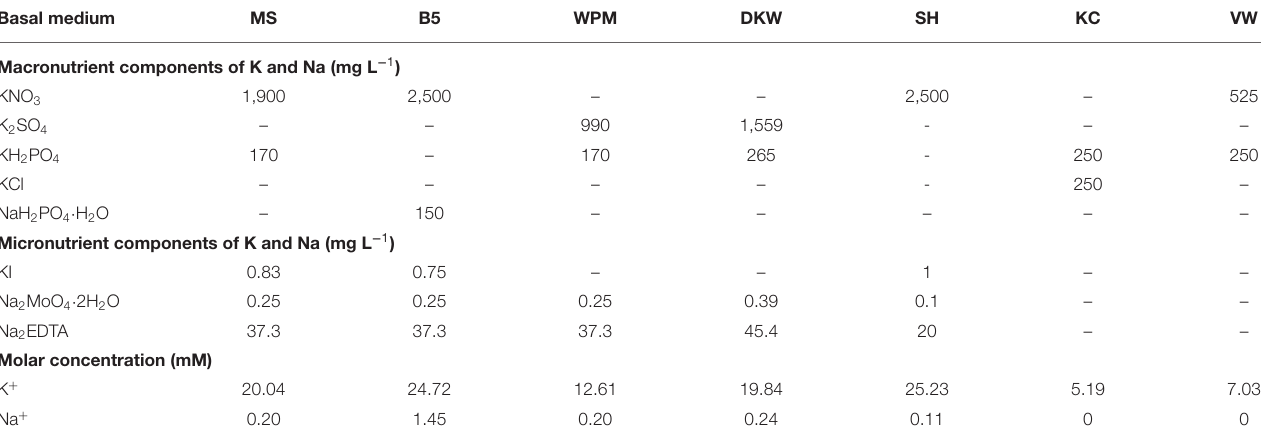
TABLE 1 | Components and concentrations of Na and K in commonly used plant tissue culture basal media. Basal medium MS